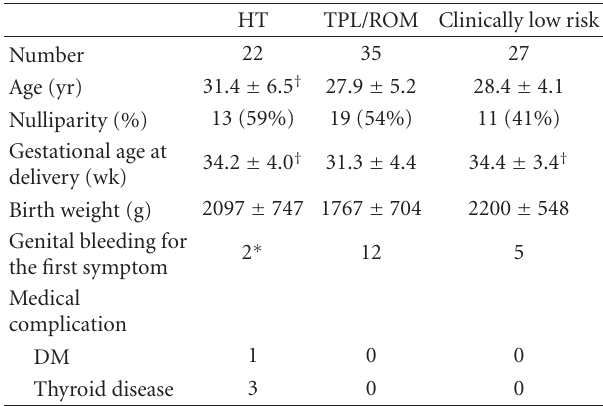
Table 2: Demographic data of women complicated with placental abruption among the HT, TPL/ROM, and clinically low risk groups.